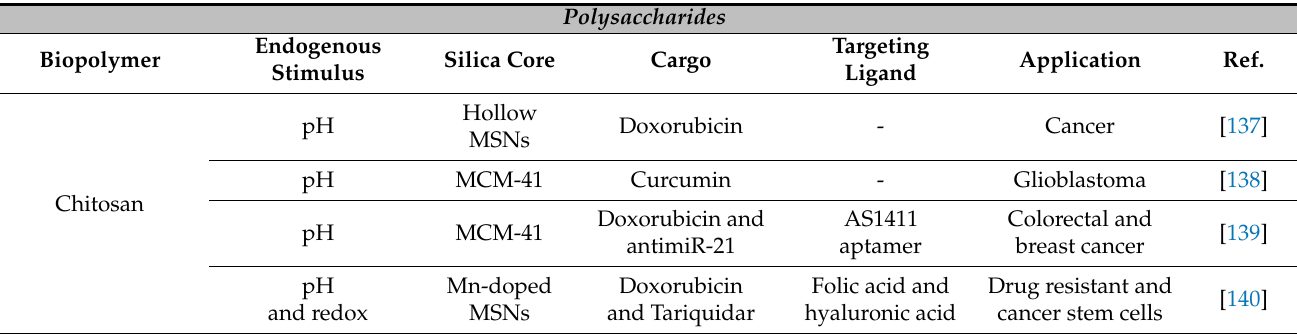
Table 1. Representative examples of MSNs coated with natural biopolymers responsive to endoge- nous stimuli for different drug delivery